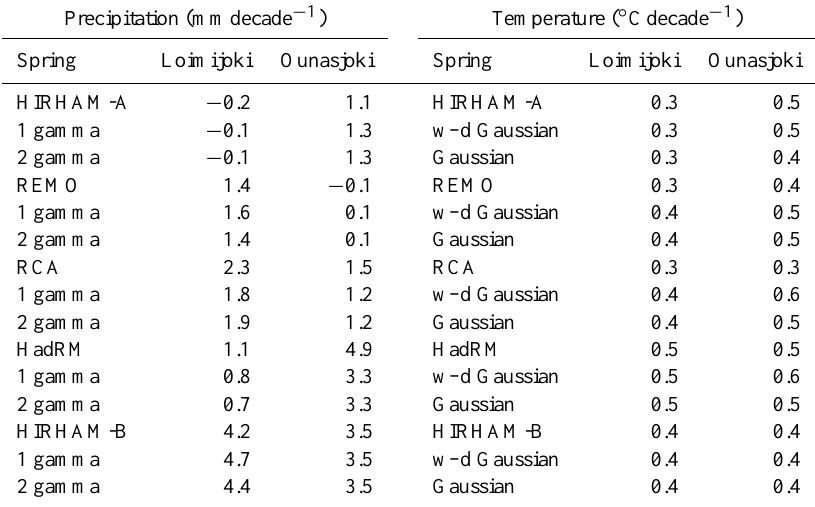
Table 4. Trends in seasonal precipitation sum (mmdecade − 1 ) and temperature ( ◦ Cdecade − 1 ) in uncorrected and DBS-adjusted RCM simu- lations. Values are shown for spring in Loimijoki and Ounasjoki to demonstrate the spatial